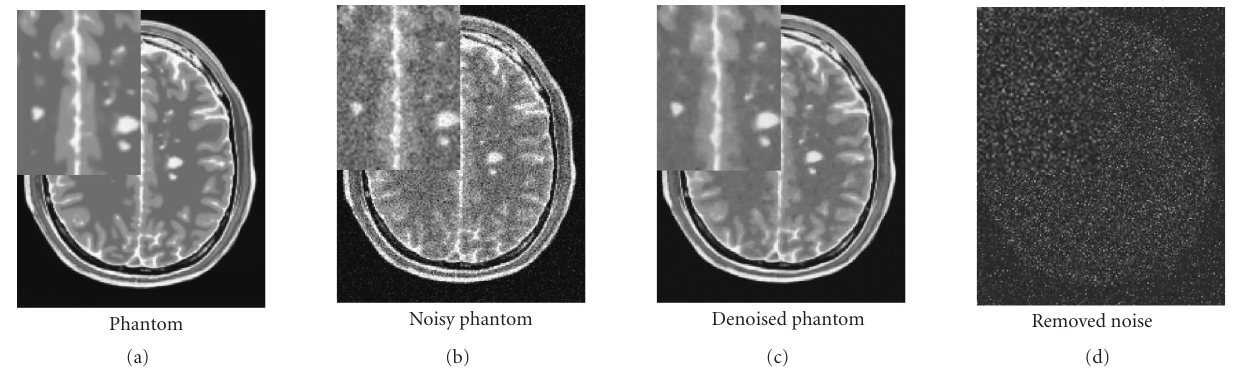
Figure 6: Fully automatic restoration obtained with the optimized blockwise NL-means with wavelet mixing filter in 3 minutes on a Dual- Core Intel(R) Pentium(R) D CPU 3.40GHz. The image is a T2-w phantom MRI with MS of 181 × 217 × 181 voxels and 9% of